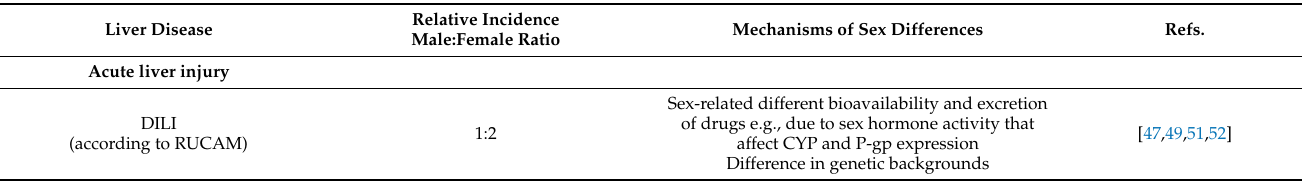
Table 1. Relative incidence and male : female ratio and sex difference in acute and chronic liver diseases. N.a., not available; DILI, drug-induced liver injury; CYP, cytochrome P450; P-gp, P- glycoprotein; NAFLD, non-alcoholic liver disease; PBC, primary biliary cholangitis; PSC, primary sclerosing cholangitis; AIH, autoimmune hepatitis; HCC, hepatocellular carcinoma; TLR, toll-like receptor; PD1, programmed cell death protein 1; PDL1, Programmed death-ligand 1; FA, fatty acid; HLA, human leukocyte antigen; E2, estradiol. Liver Disease Relative Incidence Male:Female Ratio Mechanisms of Sex Differences Refs. Acute liver injury Sex-related different bioavailability and excretion DILI of drugs e.g., due to sex hormone activity that (according to RUCAM) 1:2 affect CYP and P-gp expression Difference in genetic backgrounds